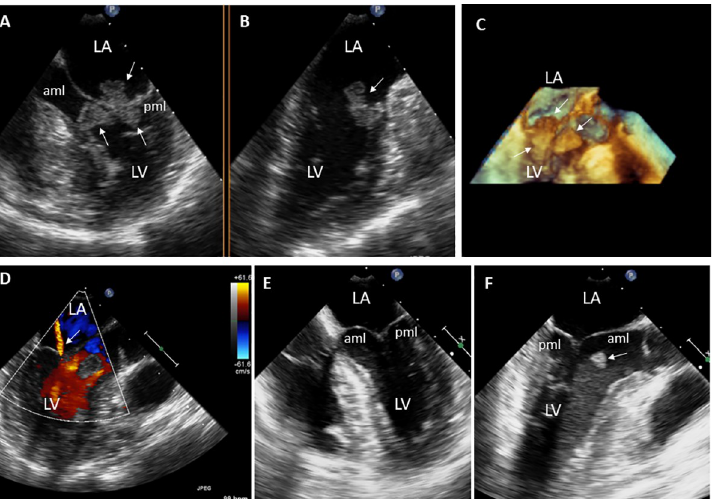
Fig 3. 31-year-old female with Libman-Sacks endocarditis complicated with acute stroke. A. This 2-D TEE view demonstrates a large (area of 2.3 cm 2 ) and tri-lobed Libman-Sacks vegetation extending from the atrial side of the mitral leaflets into the chorda tendinae (arrows). B. A second large (area of 1.1 cm 2 ) vegetation is seen attached to the basal anterior wall of the left ventricle (arrow). C. This 3D-TEE view illustrates further the large and multilobed mitral valve vegetation extending from the atrial side of the mitral valve into the chordae tendinae as well as the anterior wall vegetation (arrows). D. Color Doppler TEE demonstrates only mild mitral regurgitation (arrow). E,F. After 5 days of intravenous heparin and methylprednisolone, follow-up 2D-TEE demonstrates resolution of the mitral valve vegetations (E) and significantly smaller anterior wall vegetation (F, arrow). Abbreviations as in previous Figure.